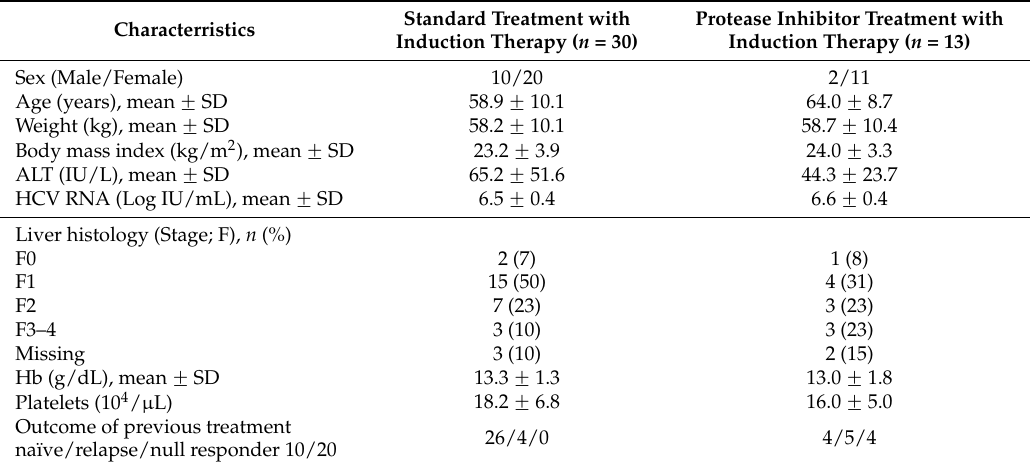
Table 1. Standard Treatment; treatment with pegylated (Peg) interferon (IFN)- α 2b and ribavirin (RBV). Protease inhibitor treatment, treatment with protease inhibitor (simeprevir or vaniprevir) plus Peg-IFN- α 2b and RBV; Induction therapy, treatment with cyclic and periodic IFN treatment which consists of induction treatment with natural IFN- β and maintenance treatment with natural IFN- α